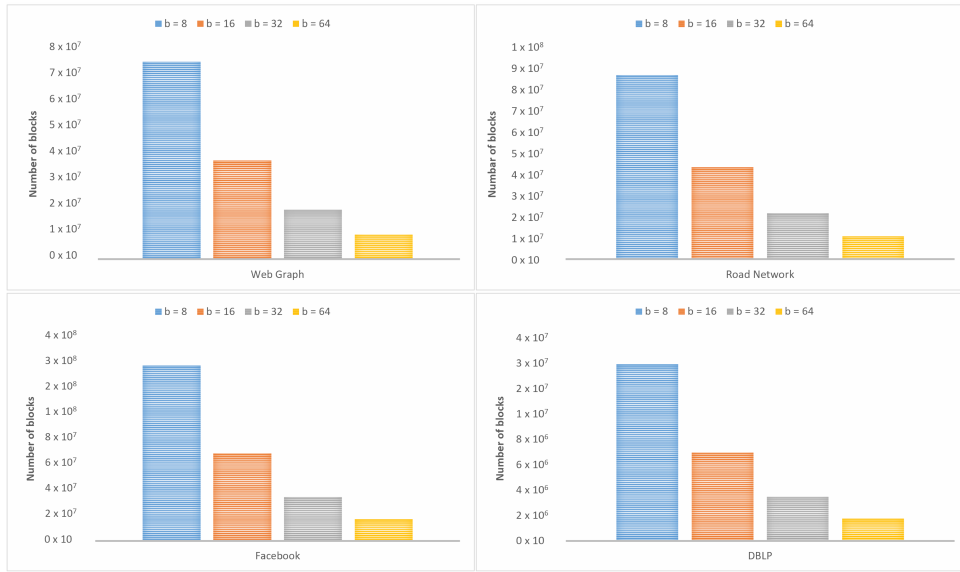
Figure 10. Number of non-empty blocks according to size of b .